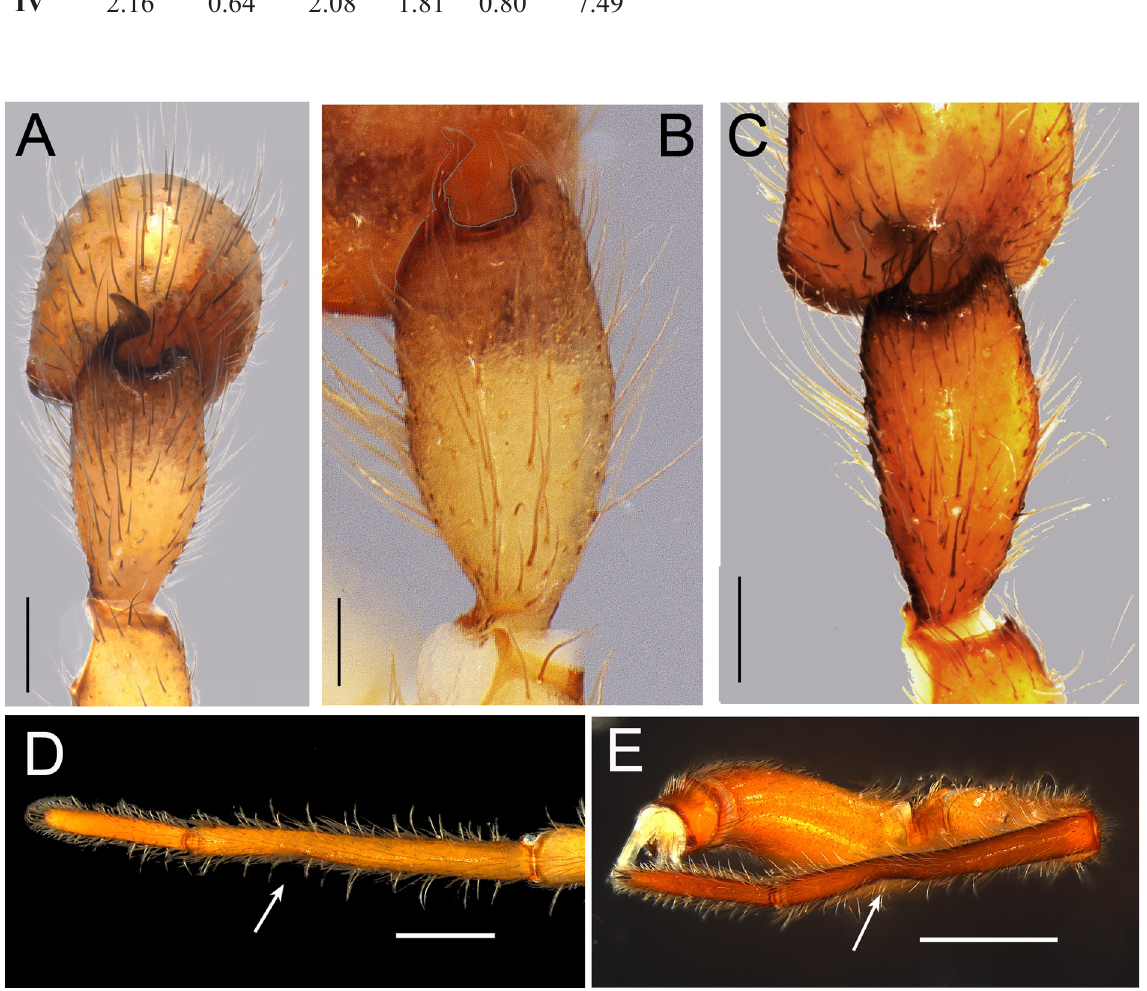
Fig. 4. A, D . Xevioso cepfi sp. nov., holotype, ♂ (RMCA_ARA_245493). B, E . Xevioso jocquei Griswold, 1990, holotype, ♂ (RMCA_ARA_156494). C . Xevioso megcummingae sp. nov., holotype, ♂ (RMCA_ ARA_236654). A–C . Palpal tibia, dorsal view. D–E . Mt I, dorsal view. Scale bars: A = 200 μm; B–C = 100 μm; D–E = 0.5